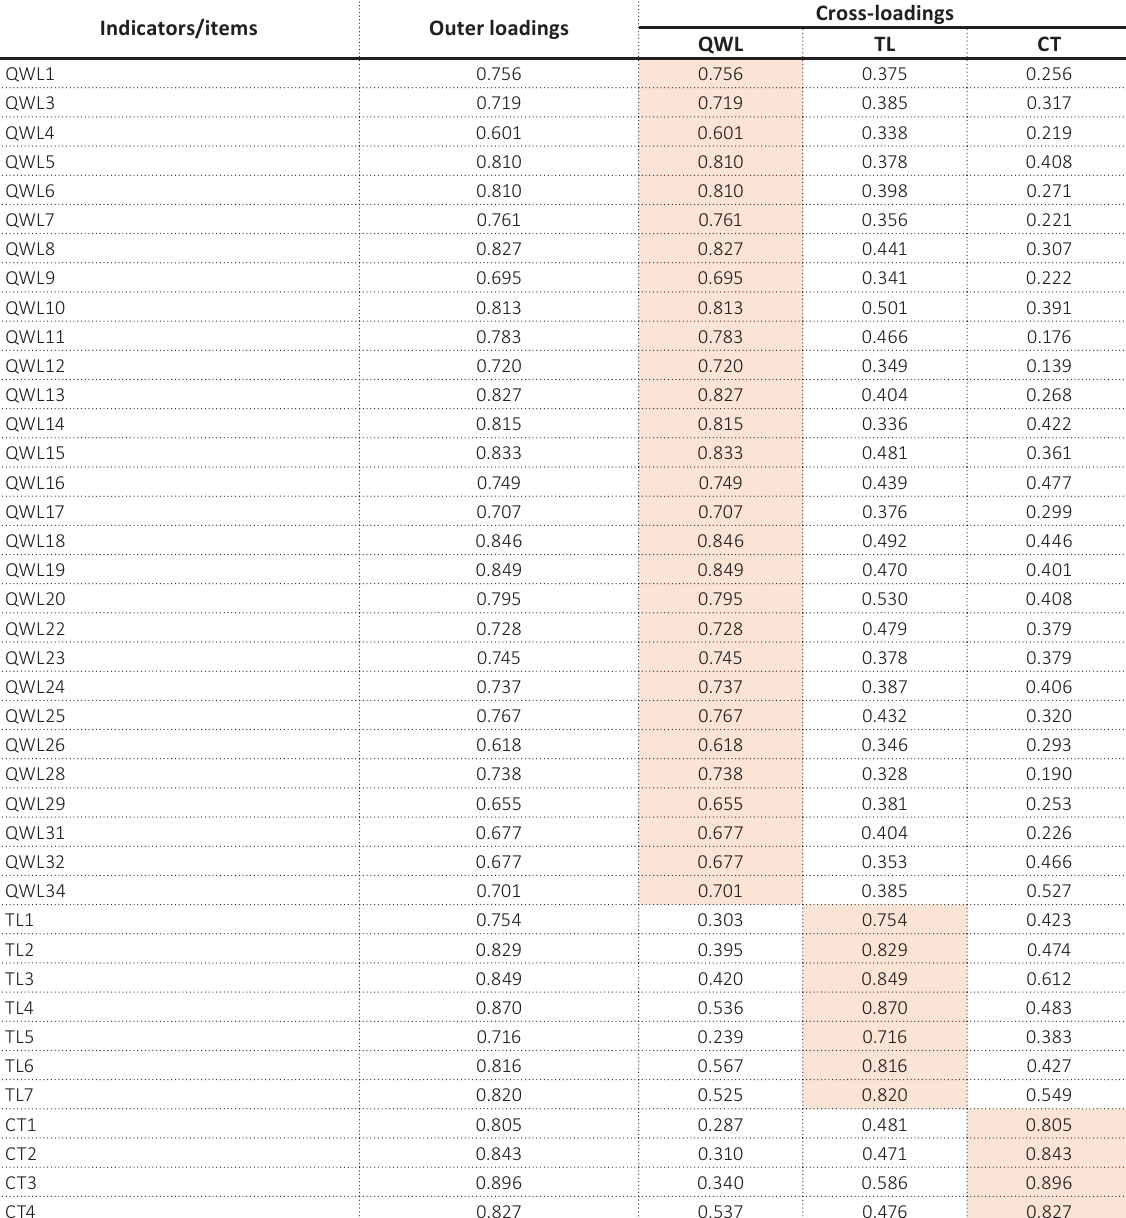
Table A1. Convergent validity and discriminant validity: Outer loadings and cross-loadings